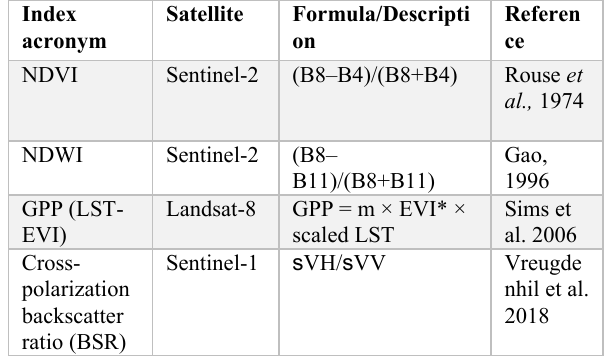
Table 3: Vegetation indices used in the